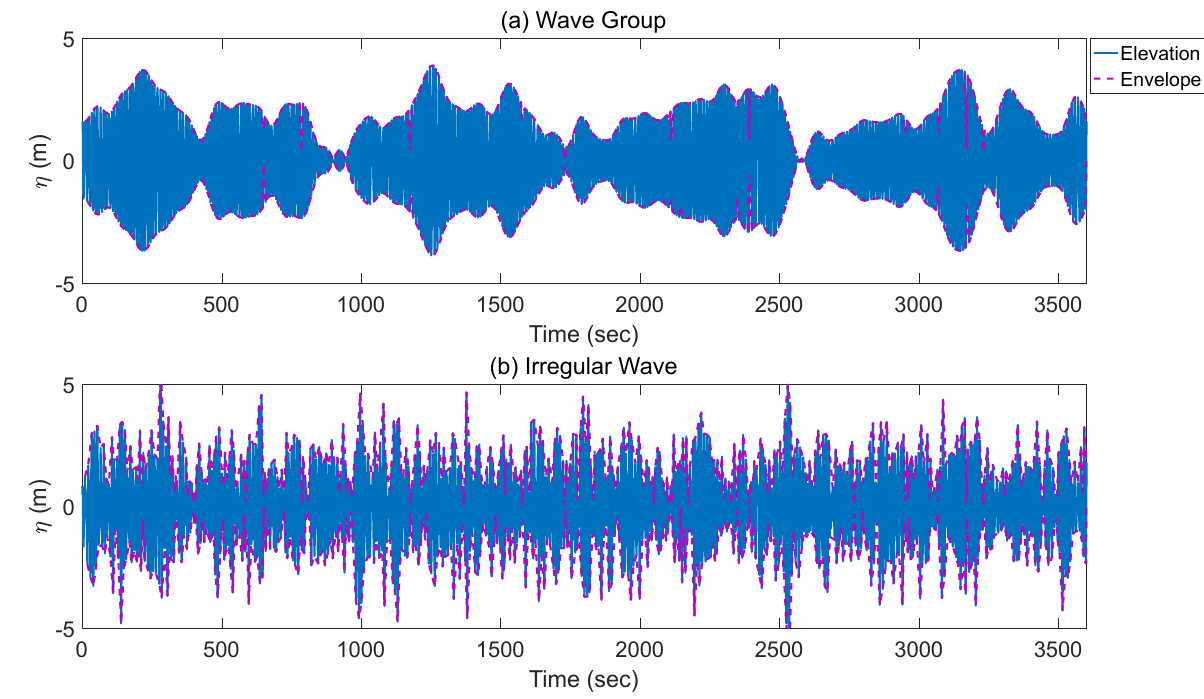
Figure 3. Time histories of irregular wave and wave group.